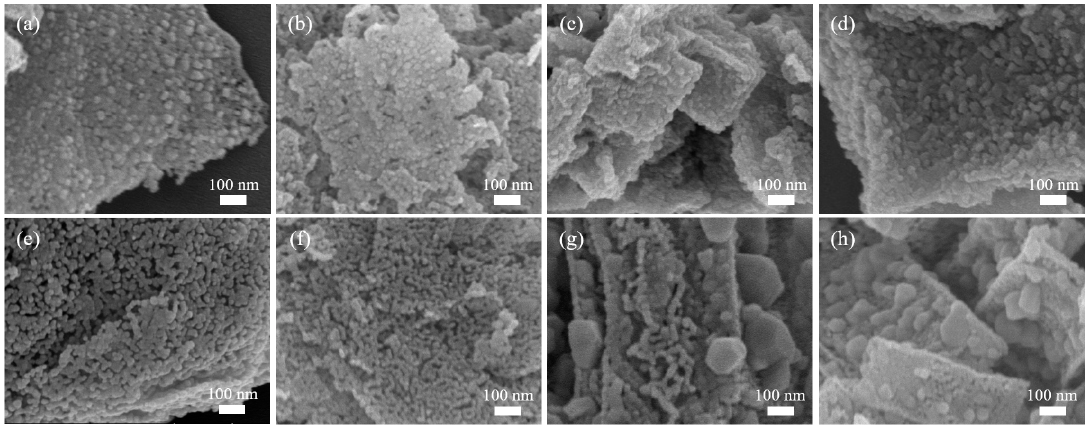
Figure 3. SEM images of ( a ) Cu-Ni_0.00_300; ( b ) Cu-Ni_0.15_300; ( c ) Cu-Ni_0.20_300; ( d ) Cu- Figure